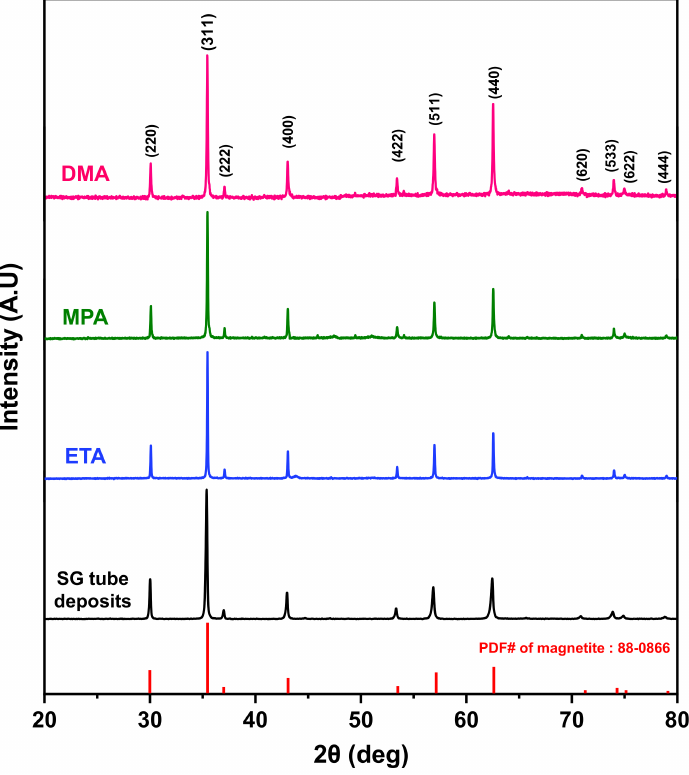
Figure 11. HR-XRD patterns of simulated deposits on an Alloy 690TT tube depending on which of the three advanced amines was used and patterns of real SG tube